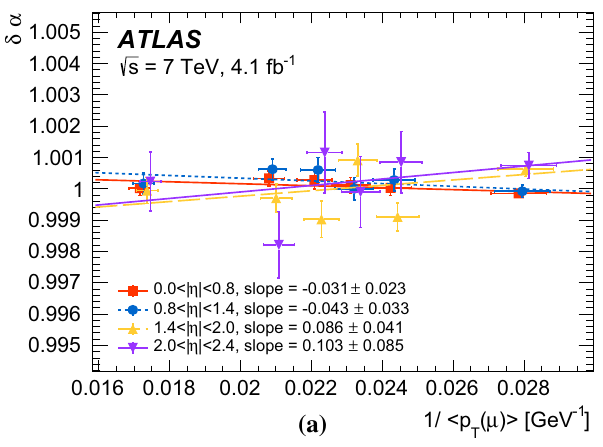
aged over φ (cid:7) . The results are obtained with the Z → μμ and E / p methods and the combination of the two. The results obtained with the Z → μμ method are corrected for the global sagitta bias. The E / p method uses electrons from W → e ν decays. The two measurements are combined assuming they are uncorrelated. The error bars on the points show statistical uncertainties only